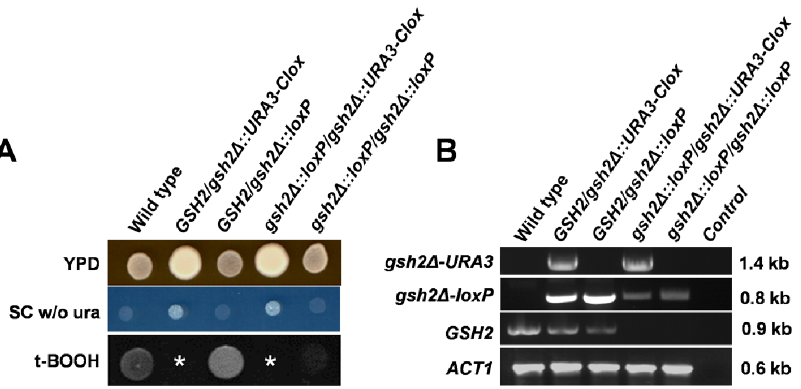
Figure 4. Validation of URA3-Clox for single marker recycling. URA3-Clox was used to generate a homozygous gsh2 D /gsh2 D mutation in C. albicans RM1000 via single marker recycling (Figure 2). (A) Confirmation of the expected phenotypes for wild type ( GSH2/GSH2 ), unresolved heterozygous ( GSH2/gsh2 D ::URA3-Clox ), resolved heterozygous ( GSH2/gsh2 D ::loxP ), unresolved homozygous ( gsh2 D ::loxP/gsh2 D ::URA3-Clox ) and resolved homozygous mutants ( gsh2 D ::loxP/gsh2 D ::loxP ). Growth media are specified on the right: w/o, without a specific supplement; *, it was not possible to test the oxidative stress sensitivity of the unresolved GSH2/gsh2 D ::URA3-Clox and gsh2 D ::loxP/gsh2 D ::URA3-Clox strains because methionine and cysteine interfere with the oxidizing agent, t-BOOH. (B) PCR confirmation of the genotypes for these mutants using primers specific for each allele (specified on the left). PCR product lengths are given on the right. ACT1 was used as a positive control, and a no-DNA control was included